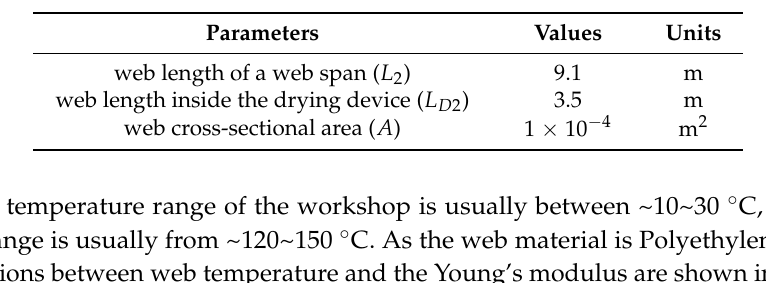
Table 2. Relations between Temperature and the Young’s modulus of Polyethylene terephthalate (PET). Web Temperate (°C) Web Temperate ( ◦